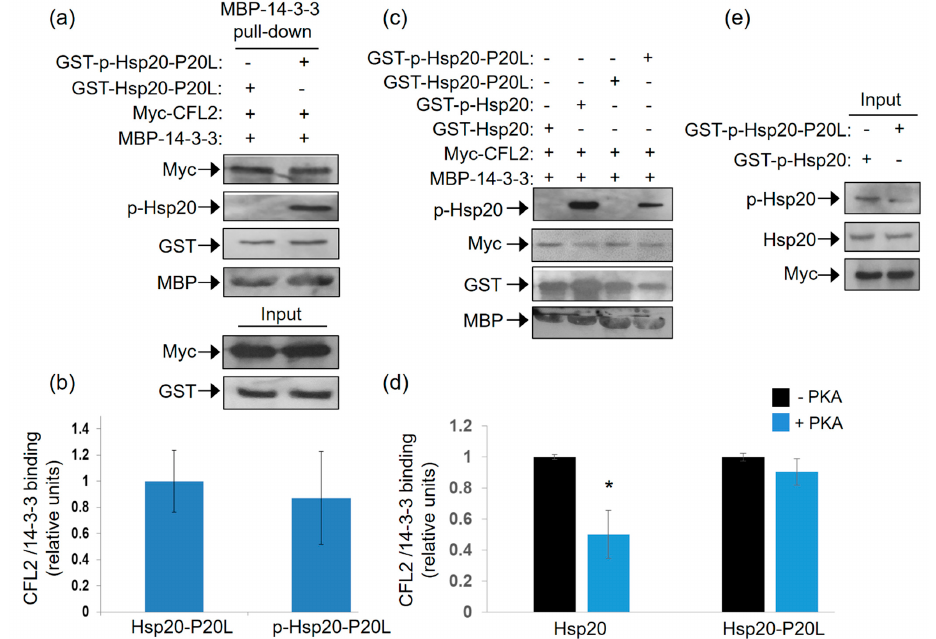
Figure 6. Ser16- Hsp20-P20L fails to displace CFL2 from 14-3-3 protein complex. ( a ) Pull down assays using MBP-14-3-3 recombinant protein and lysates from HEK 293 cells transfected with myc-CFL2. Binding of CFL2 to 14-3-3 was examined in the presence of GST-Hsp20-P20L or Ser16-phosphorylated GST-Hsp20-P20L. ( b ) Quantification of CFL2 / 14-3-3 binding in the presence of GST-Hsp20-P20L or Ser16-phosphorylated GST-Hsp20-P20L. Data are the mean ± SD; n = 3. ( c ) Representative pull down assay showing the diminished e ff ect of Hsp20-P20L in competing with CFL2 for 14-3-3 binding, when compared to WT Hsp20. ( d ) Quantification of CFL2 / 14-3-3 binding in the presence of GST-Hsp20 or GST-Hsp20-P20L (* p < 0.05 vs. Hsp20-PKA, t test, two-tailed; n = 3). Data are the mean ± SD; n = 3. ( e ) Reduced Ser16 phosphorylation of Hsp20-P20L mutant, in comparison to Hsp20-WT